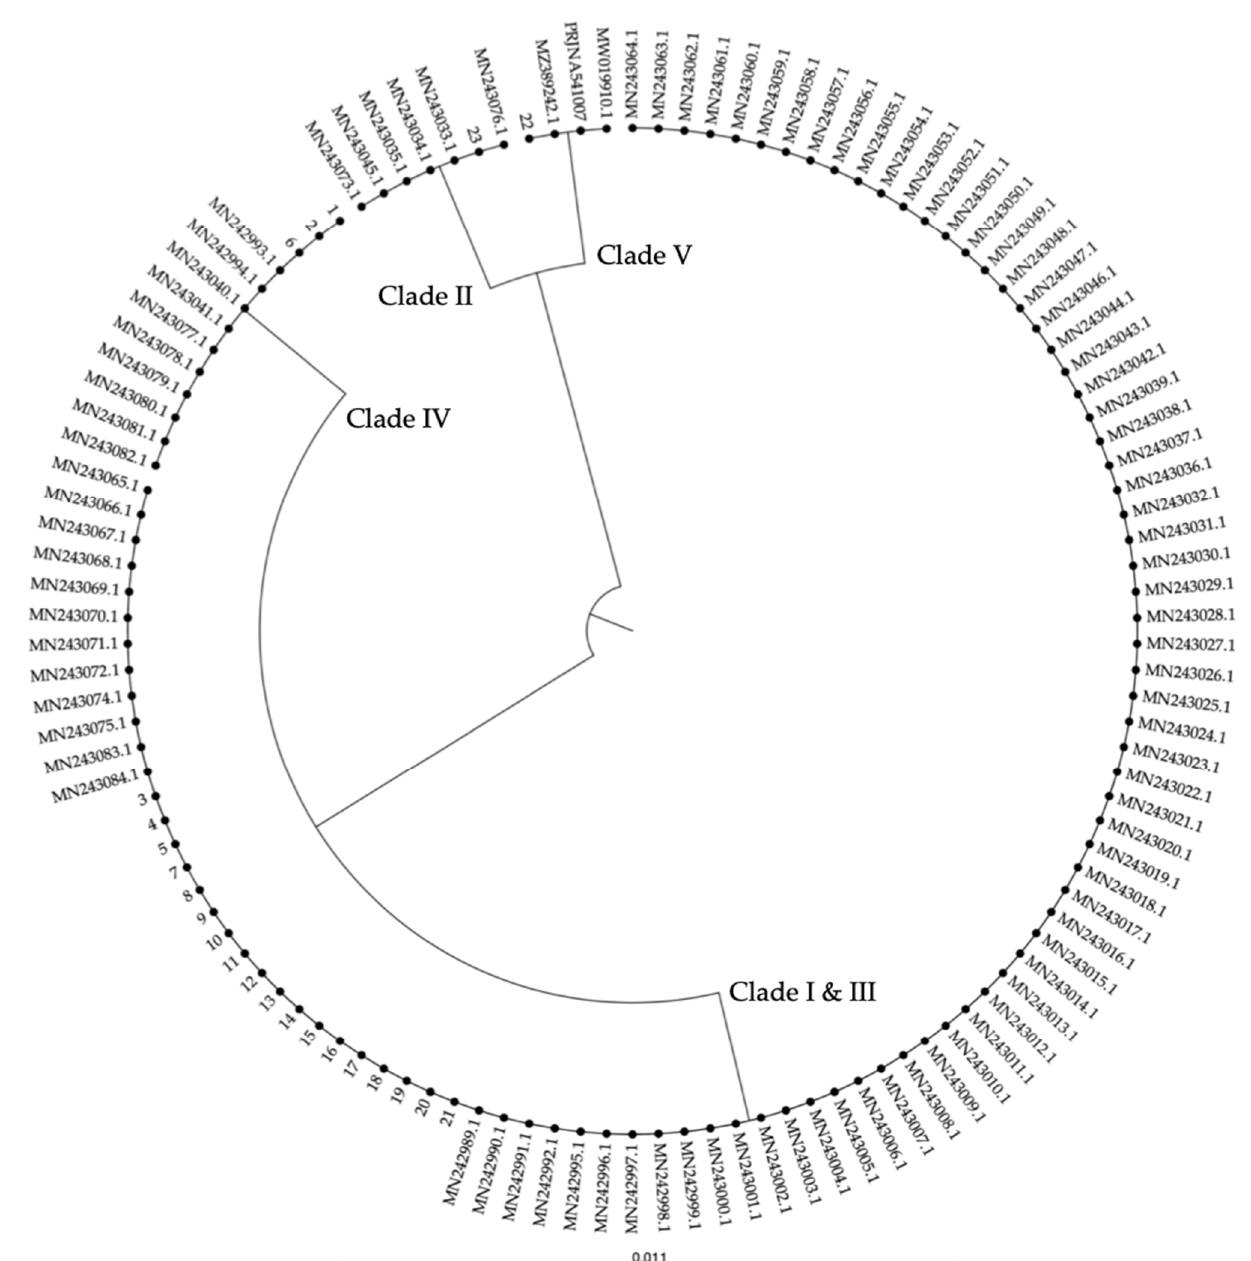
Figure A1. UPGMA dendrogram of a 248–251 bp ITS alignment of sequences of 121 C. auris strains: 96 typed strains from four clades [31] and three clade V strains [12,21,22], represented by their GenBank accessions, and 23 strains from our in-house collection, represented by the numbers 1 to 23 (see Table A2). Four ITS-based clusters are shown: clades I and III, clade II, clade IV, and clade V. The scale bar represents the percentage of nucleotide variation.